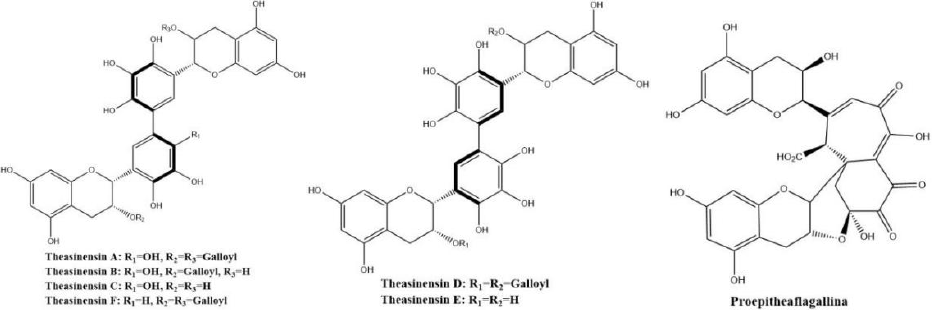
Figure 8. Structures of theasinensins and proepitheaflagallina.